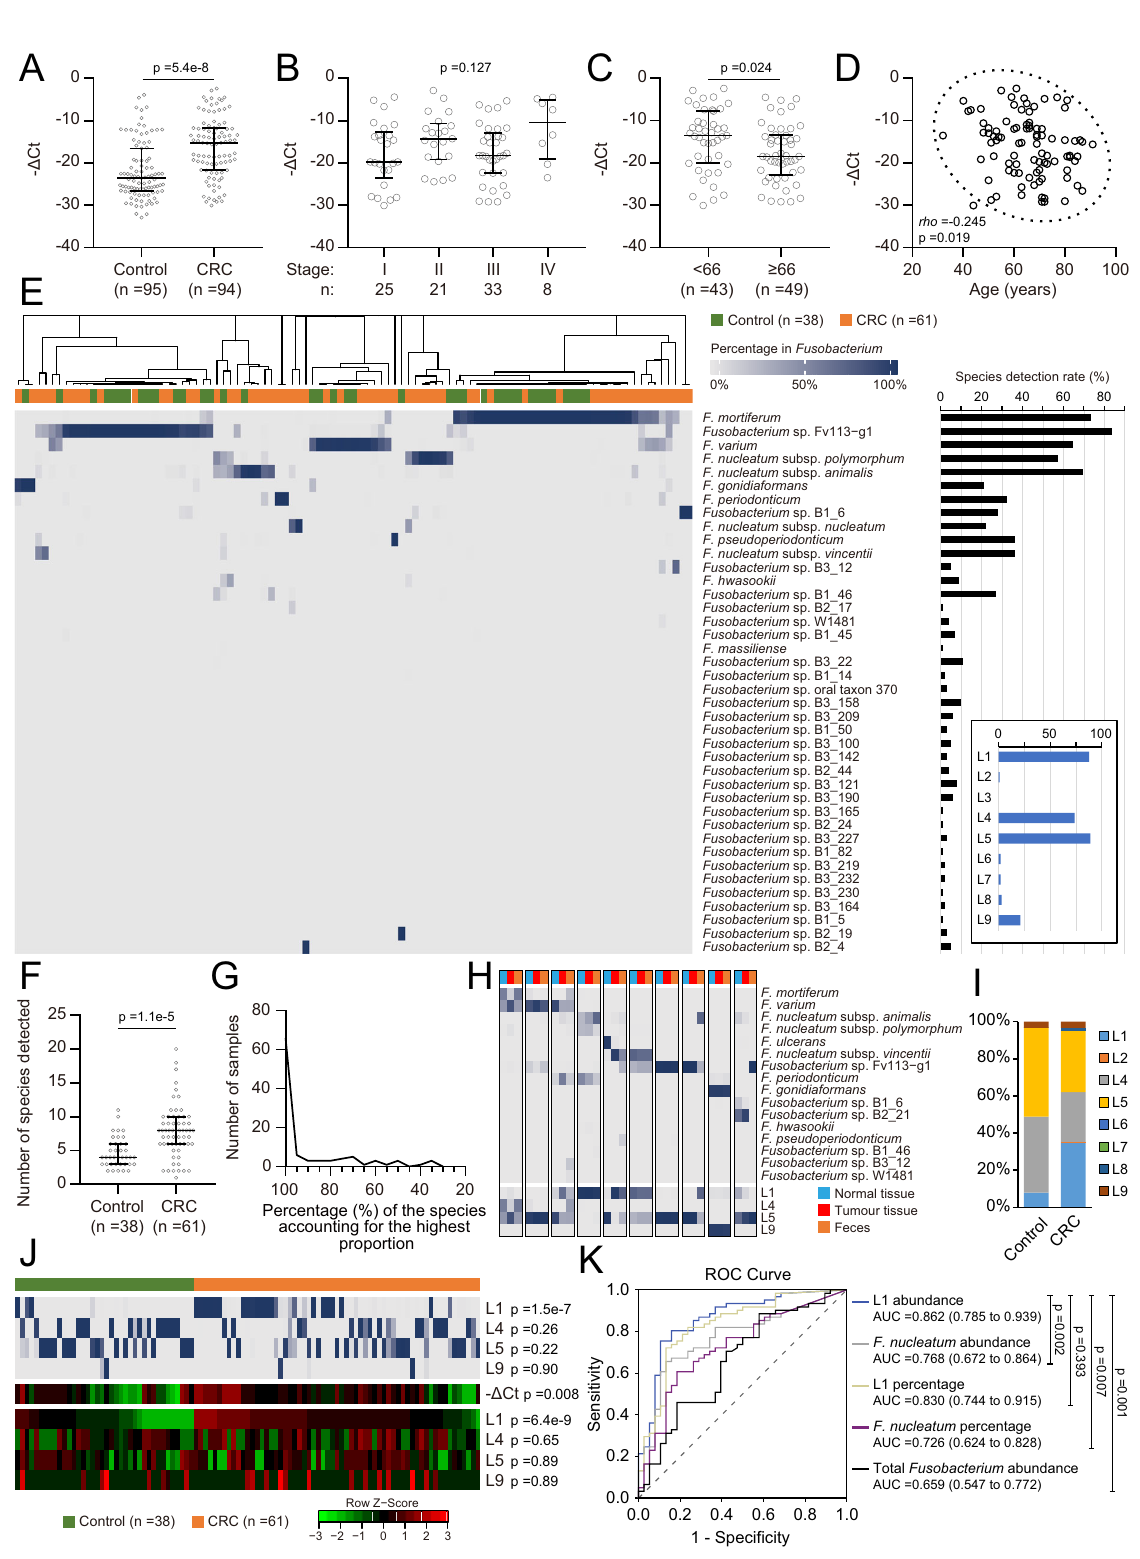
gonidiaformansF. periodonticum F. Fusobacterium sp. B1_6 F.